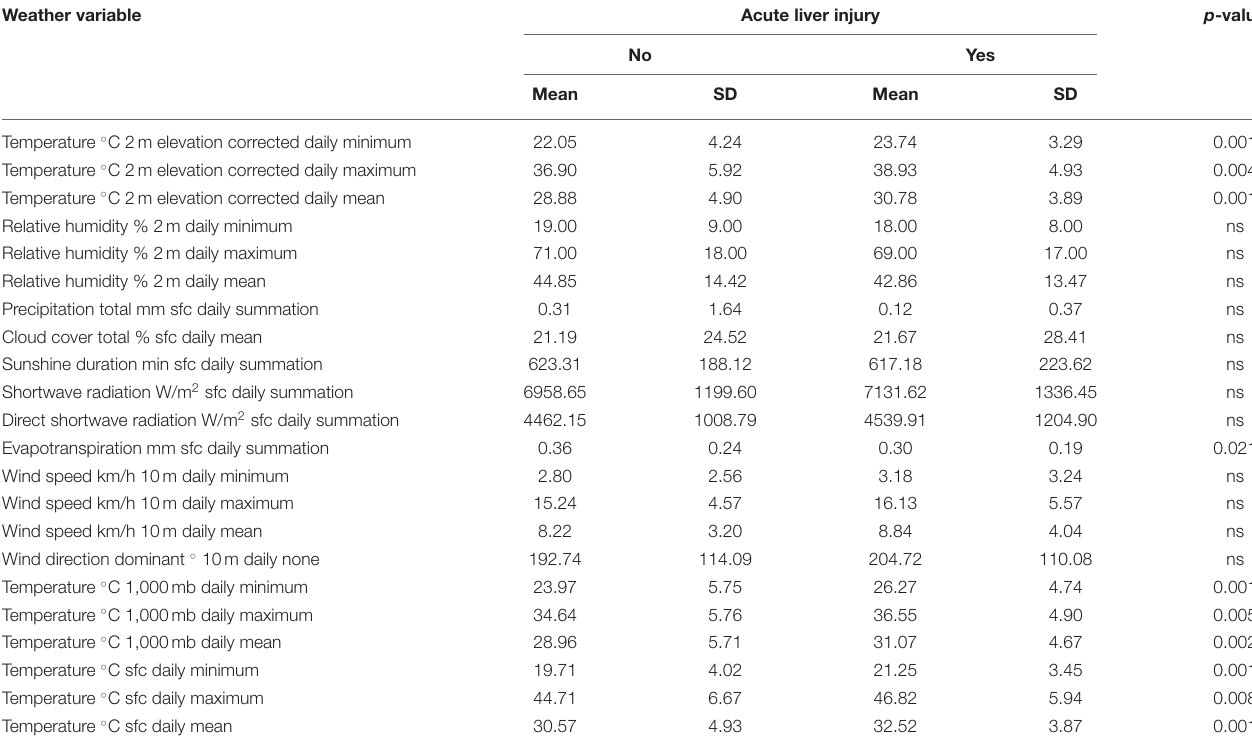
TABLE 3D | Difference in day-of-admission weather variables in Dubai City between COVID-19 patients’ clinical outcomes: Acute liver injury. Weather